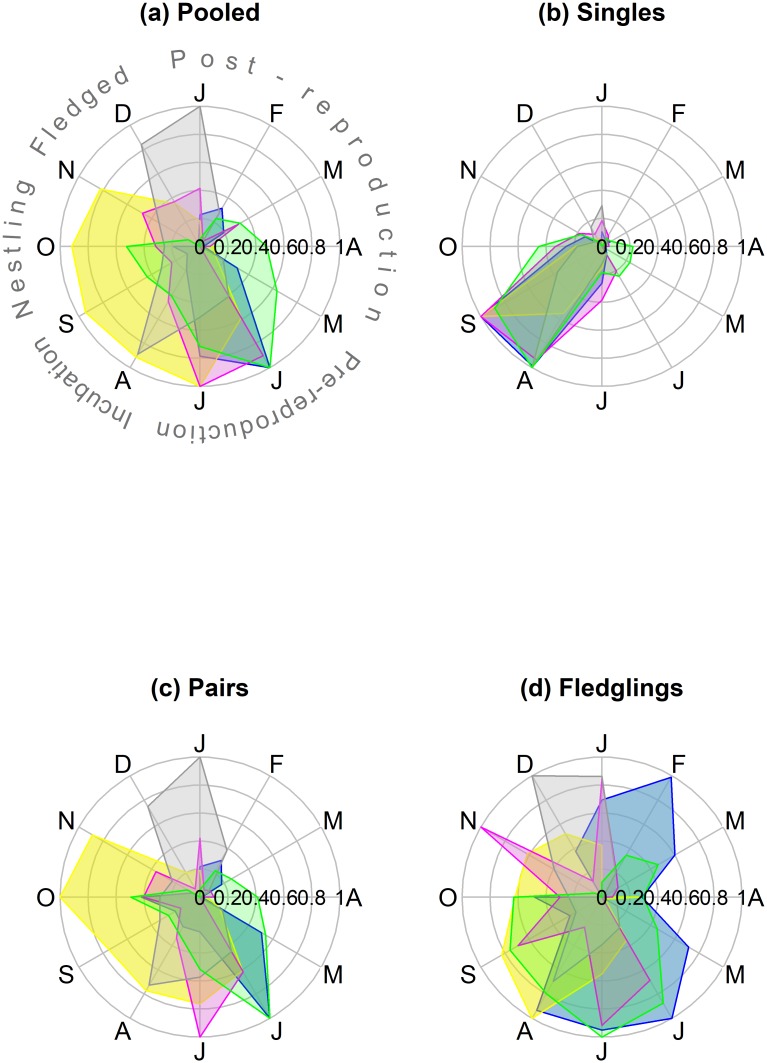
Radial plots of the seasonal component resulting from the decomposition analysis of monthly counts of Blue-fronted Amazons (see Methods) stratified by group size in five roosts in the southern Pantanal of Brazil.Seasonal components were range standardized in order to obtain values of between one and zero. “All Parrots” refers to the numbers of parrots arriving at each roost irrespective of the flock size, “Pairs” refers to the number of pairs, “Singles” refers to the number of singletons, and “Fledglings” refers to the number of parrots arriving at the roosts in family groups of three to six birds. Blue = Roost 1, violet = Roost 2, yellow = Roost 3, green = Roost 4, gray = Roost 5. Information about the reproductive cycle of the Blue-parrot Amazon [41] appears in the upper left graph. Counts were carried out from July 2004 to July 2009. Graphical results of the STL decomposition analyses of each flock-size strata in each roost are supplied (S2–S21 Figs).